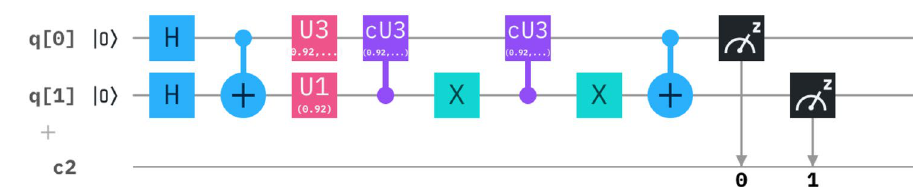
Figure 7. Measurement bases for the calculation of average values of <σ z σ z > for N = 2 in